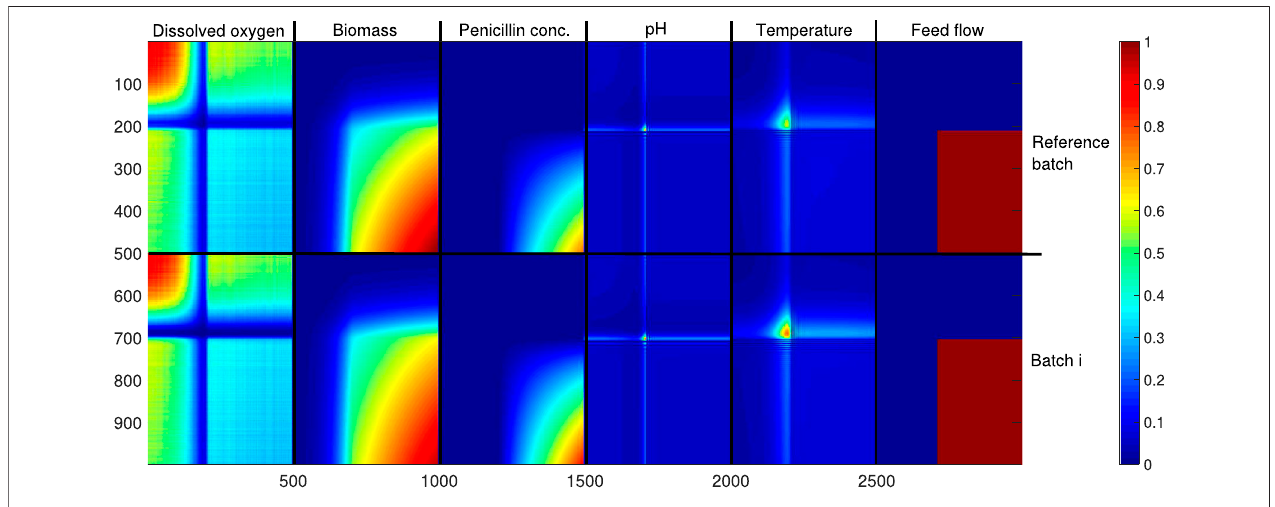
FIGURE 3 | Cross-auto-correlation matrix for two batches of the Pensim process.